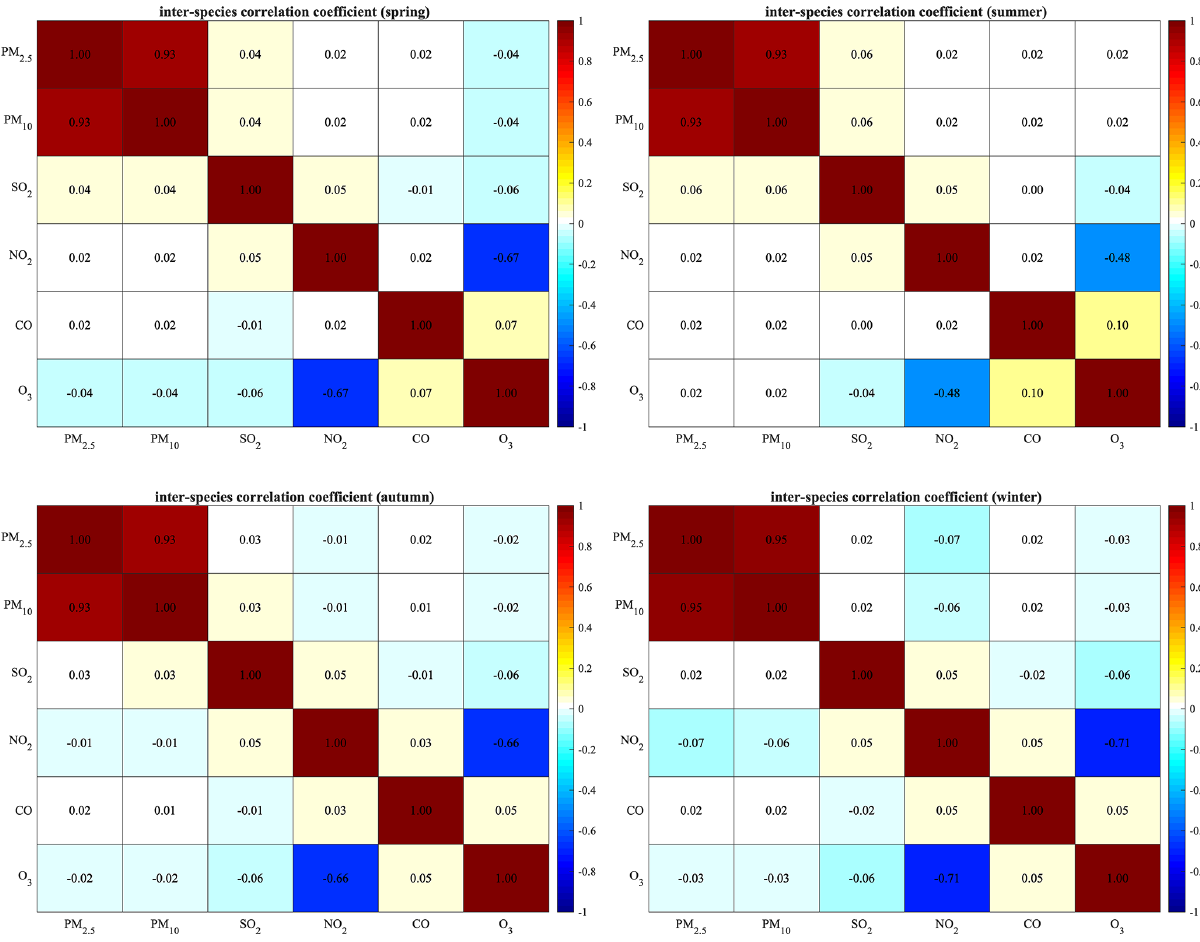
Figure B2. Correlations between species in the background error covariance matrix, estimated from the LETKF ensemble averaged in different seasons from 2013 to 2018. The global mean of the covariance estimated for each station is